Question: Does the plotted quantity increase or decrease?
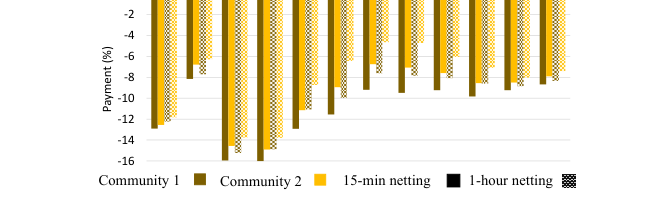
Answer: increasing